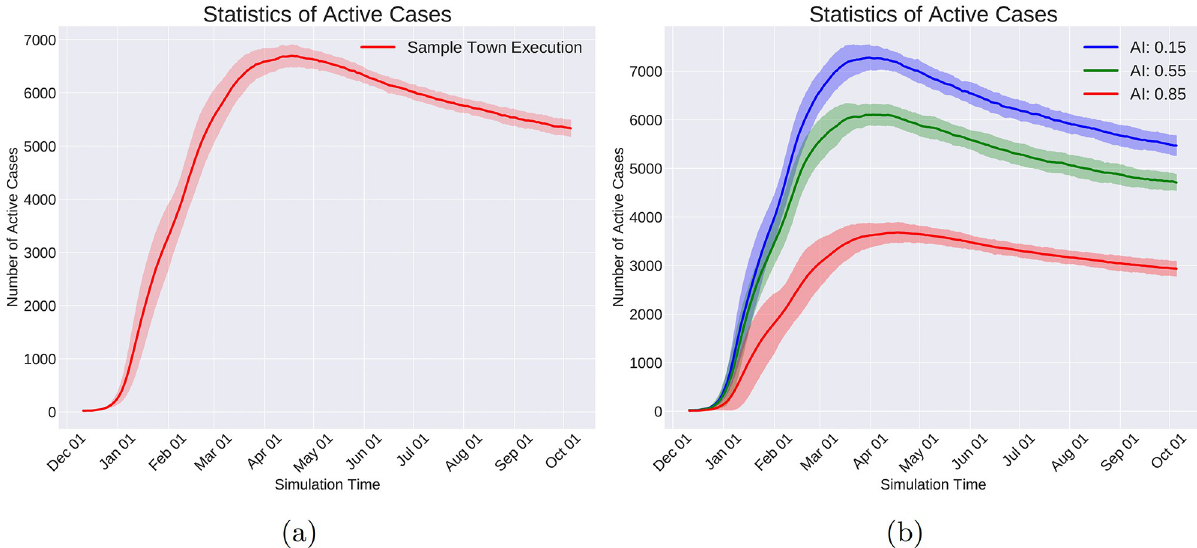
Fig 10. a) The simulation is executed without any control measure, and the number of infected individuals is plotted versus time for the period of 10 months. The halo around the solid curve is the confidence interval obtained by multiple runs. At each round, the parameters of the population and the disease are re-sampled from the specified distributions. b) The curves of the number of active cases versus time are plotted for different immunity rates. The immunity rate is sampled from three uniform distributions with different mean values. As can be seen, more significant immunity rates give rise to flatter curves. Note that AI initials in the legend stand for Average Immunity, which is the mean of the uniform distribution from which each curve’s immunity rate is